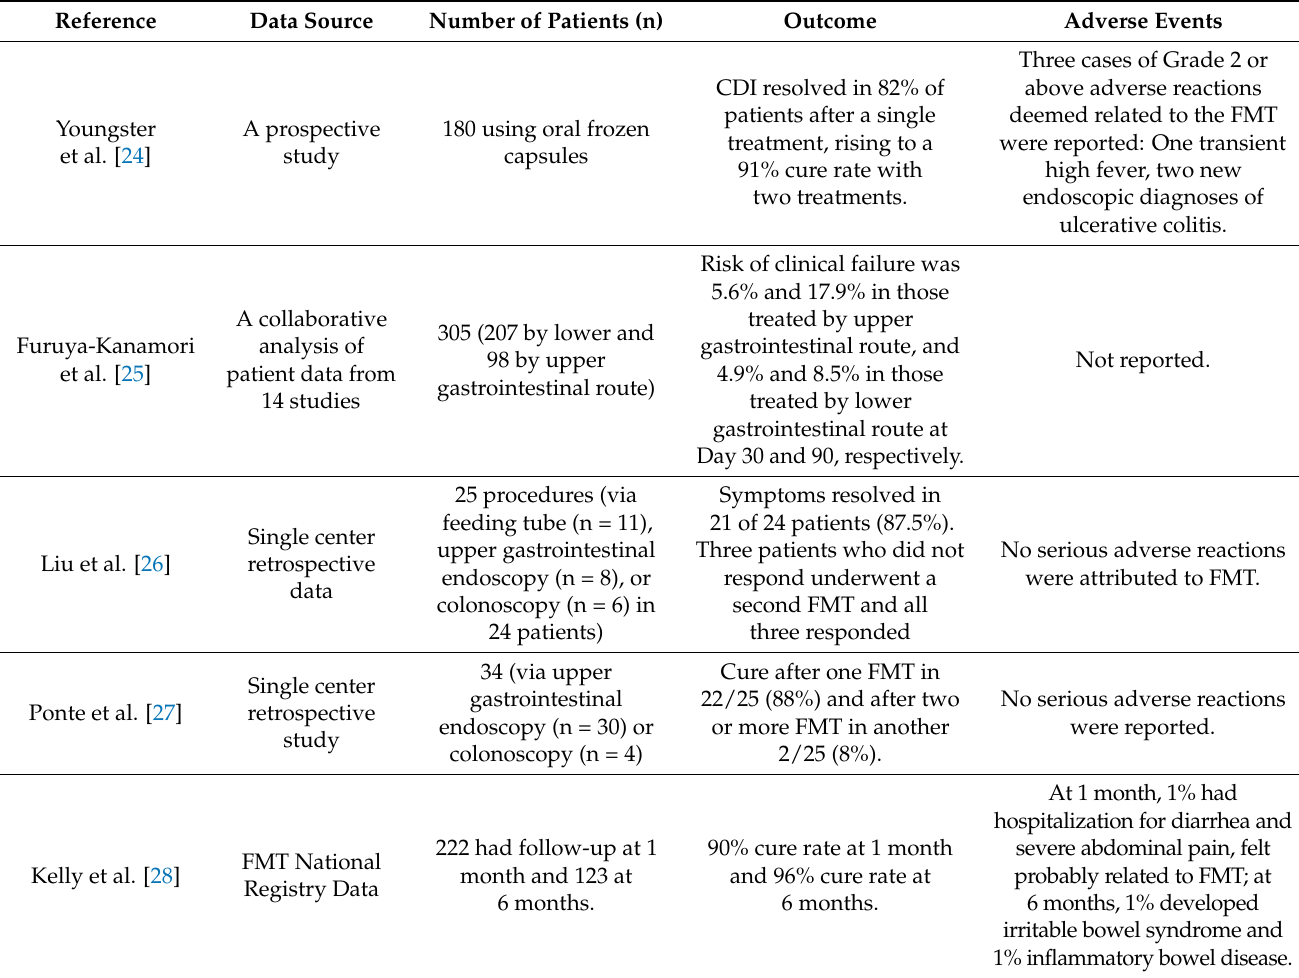
Table 1. Results of selected studies on the use of FMT for relapsed/refractory